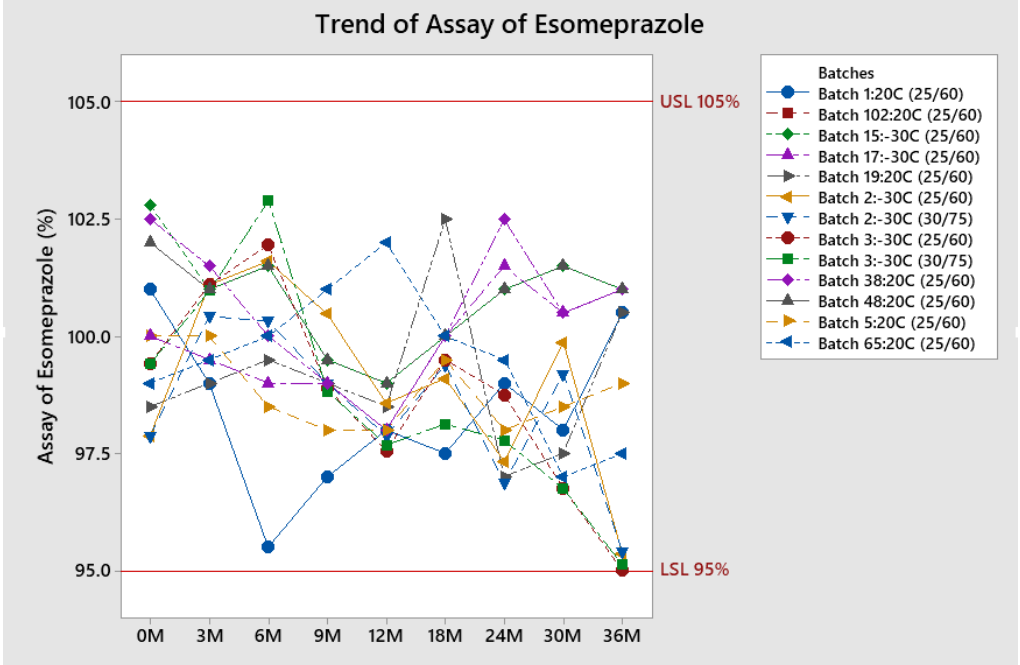
Figure 6. Trend of Esomeprazole results for stability batches.